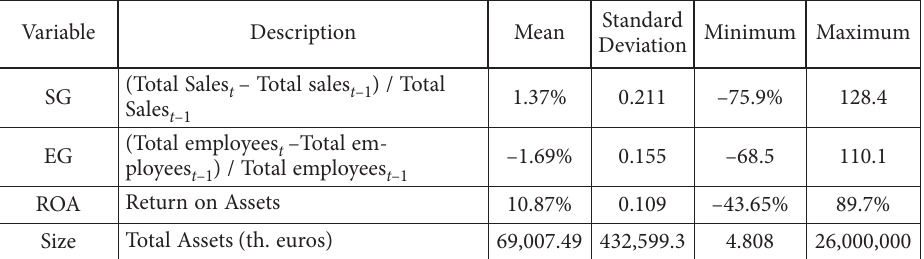
Table 1. Summary statistics (sample period 2000 to